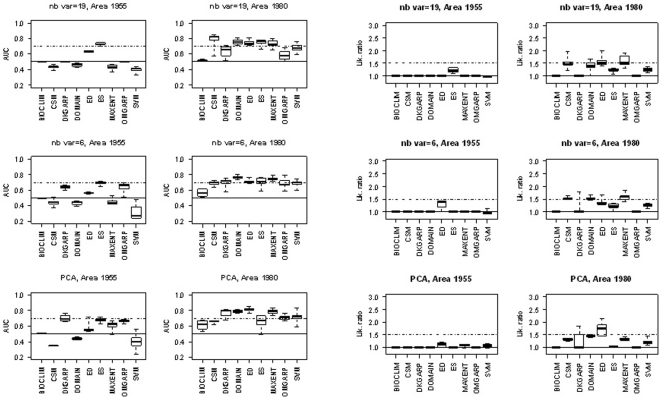
Box plots of AUC values and likelihood ratios (sensitivity = 0.95) computed for the nine models with 19 variables, 6 variables, or three principal components (PCA) for training datasets generated from two areas (1955 and 1980).Continuous and dashed lines correspond to AUC = 0.5 or ratio = 1 and AUC = 0.7or ratio = 1.5 respectively.